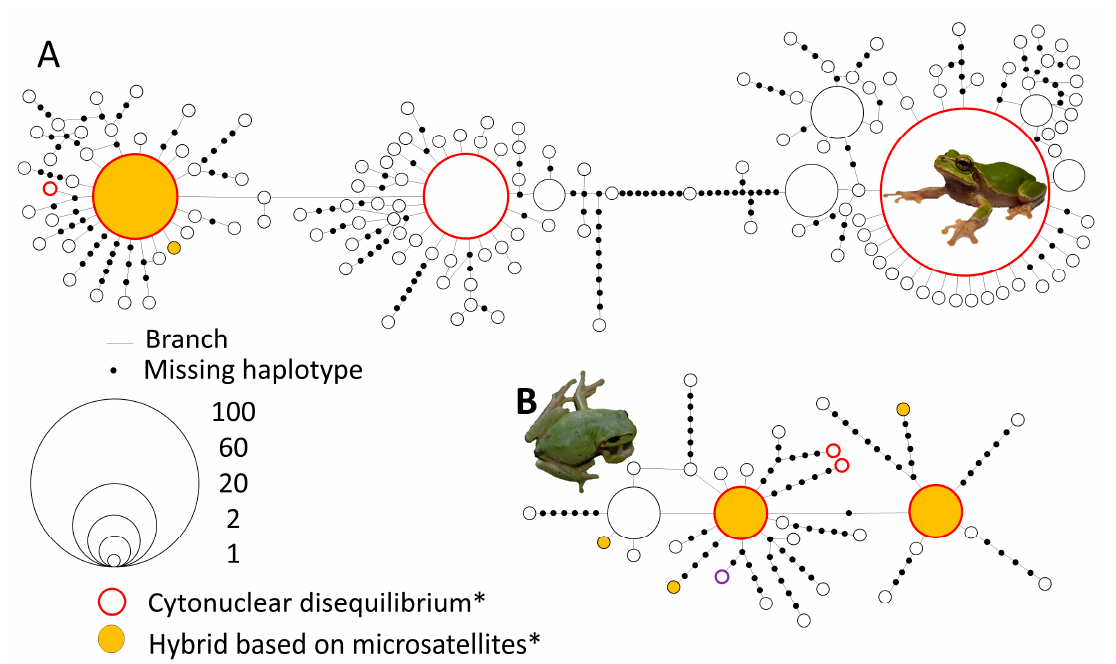
Figure 2. Haplotype network for (A) Dryophytes japonicus ( n = 317) and (B) Dryophytes suweonensis ( n = 87). The figure was drawn in TCS (v. 1.21 software: [61]) with a fixed connection limit at 500 steps (estimated) and all other parameters set as defaults. The star networks indicate pronounced population expansion (both species), whereas the missing haplotypes may be related to local extinctions among other possibilities such as inadequate sampling ( D. suweonensis ). *Denotes the presence of at least one individual in cytonuclear disequilibrium / hybrid for the haplotype highlighted.